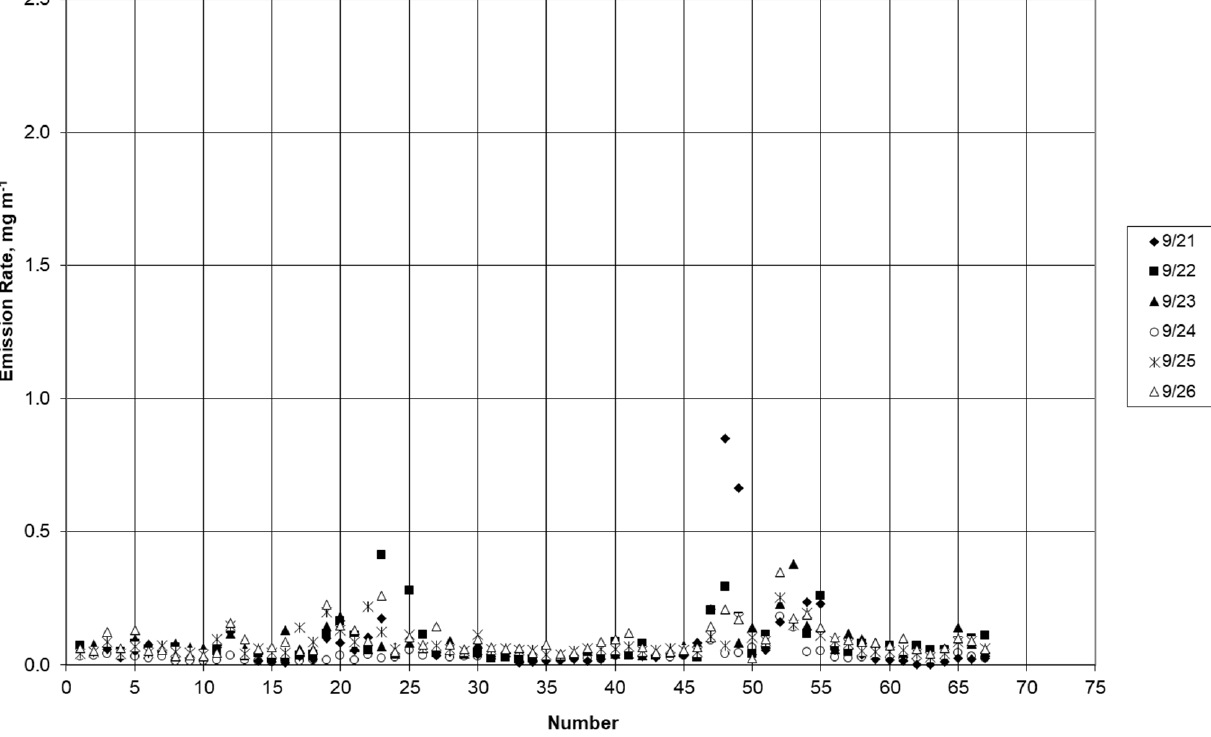
Figure 6. Plot of PM 10 emission rate by segment number starting Thursday September 21 st .